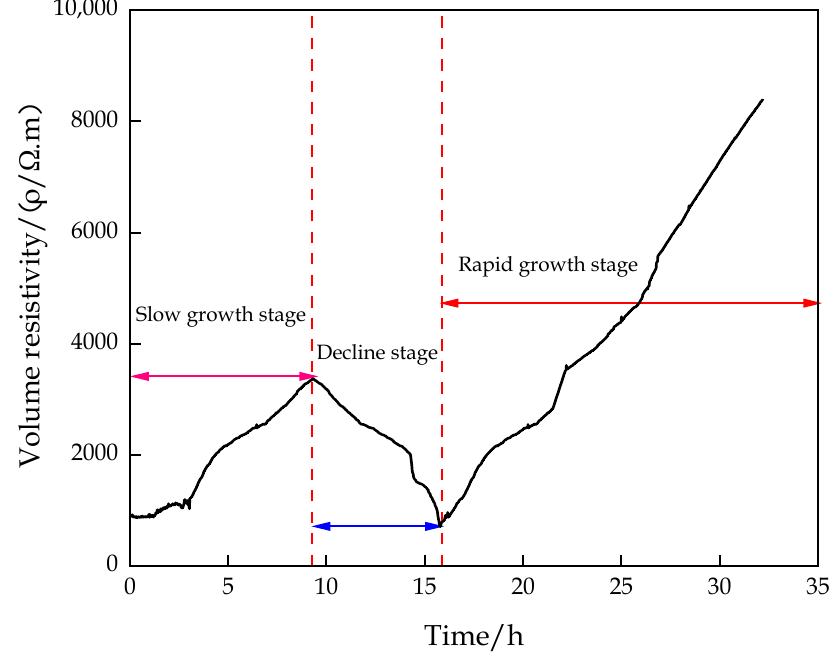
Figure 11. Phase variation characteristic curve of volume resistivity.